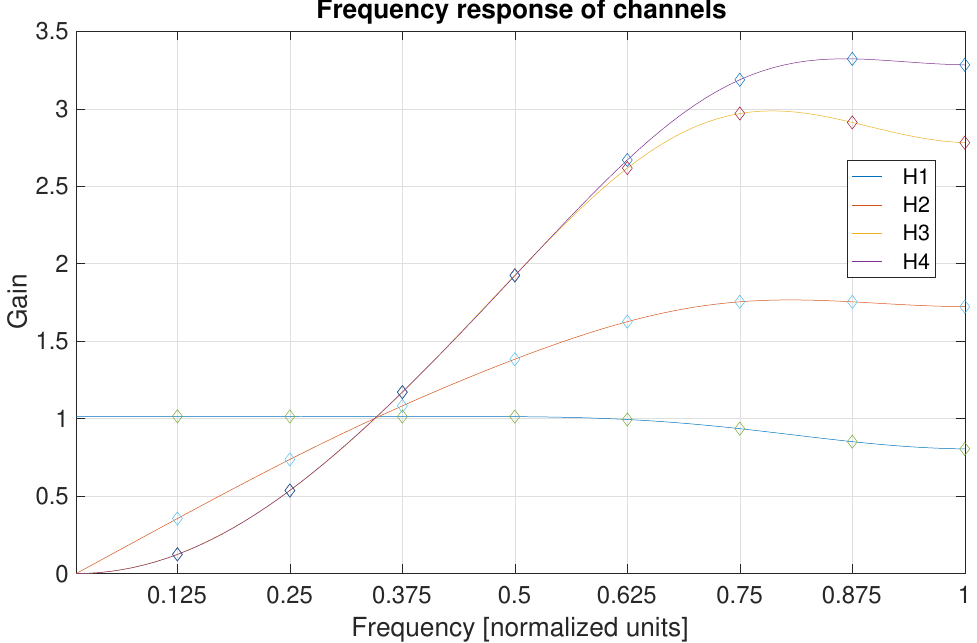
Figure 3. The amplitude frequency response of the 4 channels highlights the behavior of the channel hosting the position sensor (blue), the velocity sensor (red), and the acceleration sensors (yellow and magenta) within the input bandwidth. The diamond markers highlight the points considered at the identification stage.